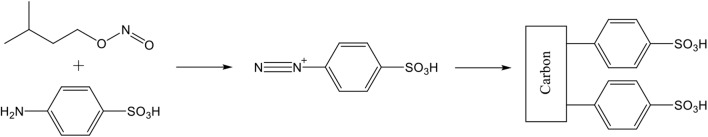
Diazonium coupling on carbon materials for sulfonic acid grafting.